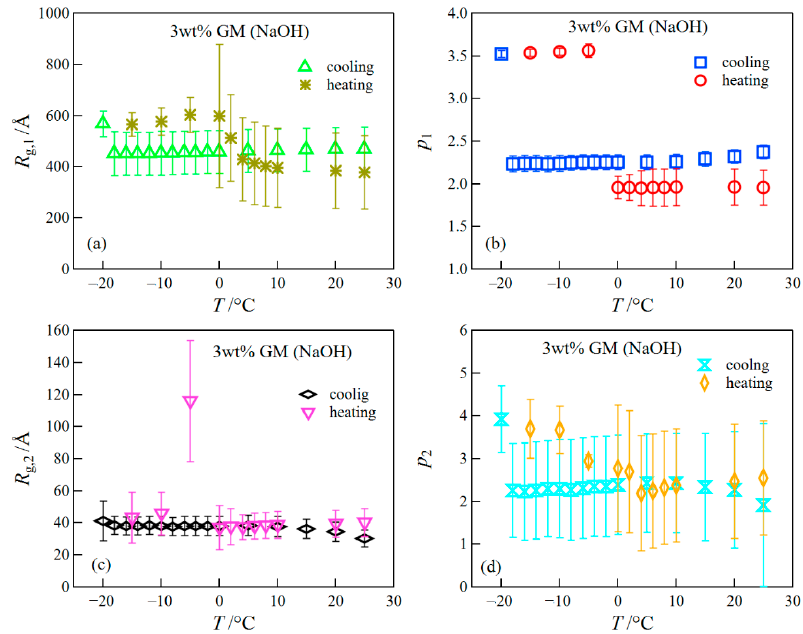
Figure 7. Temperature dependence of parameters ( R g,1 ( a ), p 1 ( b ), R g,2 ( c ), and p 2 ( d )) obtained in the fitting analysis. See Equation (1) about each parameter.